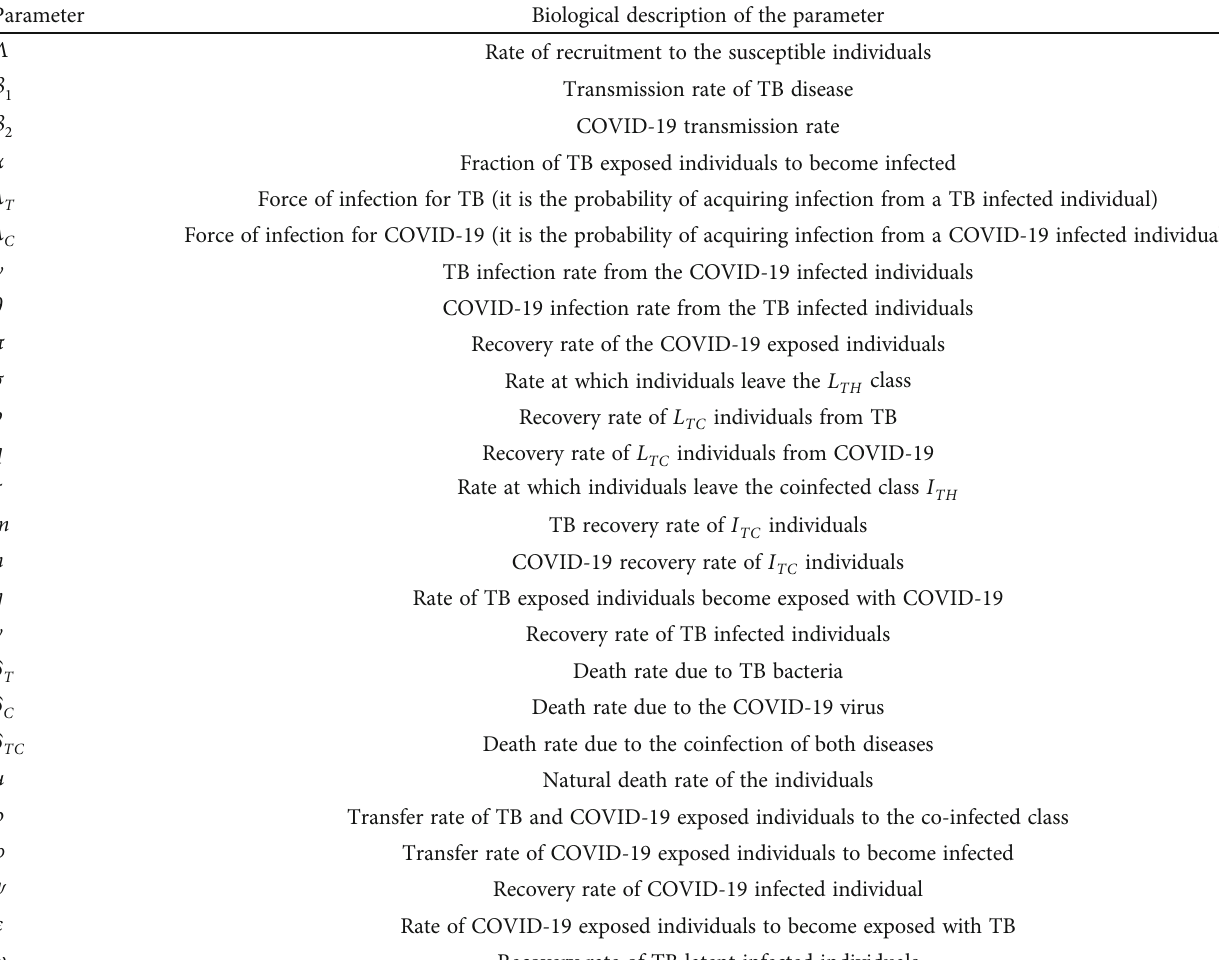
Table 1: Description of the model